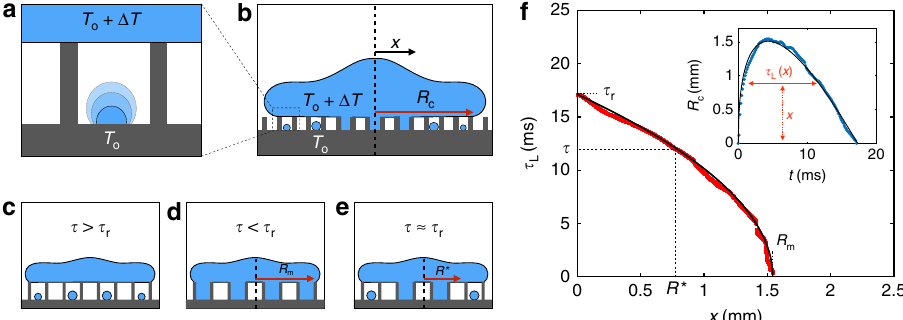
Fig. 3 Dynamics of adhesion. a Elementary cell containing a growing condensation nucleus fed by the hot water above. b Sketch of the spreading drop. x is the radial distance from the impact point and condensation nuclei are larger at small x , due to a higher local contact time τ L . c – e Pinning mechanism as a function of τ and τ r , the condensation and bouncing times. In the fi rst case ( c , τ > τ r ), there is no bridge between the substrate and the drop; in the second case ( d , τ ≪ τ r ), bridges form with a probability N below the drop; in the third case ( e , τ ≈ τ r ), bridges (with the same probability N ) only connect the drop on a radius R* < R m , the maximum contact radius at impact. f Local contact time τ L as a function of the distance x for a drop bouncing on surface B ( R = 1.4 mm and V = 40 cms − 1 ). The solid line shows equation (4), with τ r = 17.4 ms and R m = 1.55 mm. For τ L > τ , the drop is bridged to the surface on a disk with radius x = R* ( τ ). Insert: contact radius R c as a function of time for the same experiment. The solid fi t R c ( t ) ≈ 2( RVt ) 1/2 − (3 γ /2 ρ R ) 1/2 We 1/4 t is discussed